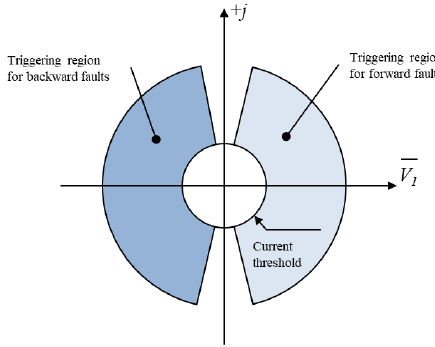
Figure 3. Operating characteristic of the directional criteria for three-phase short circuit faults.